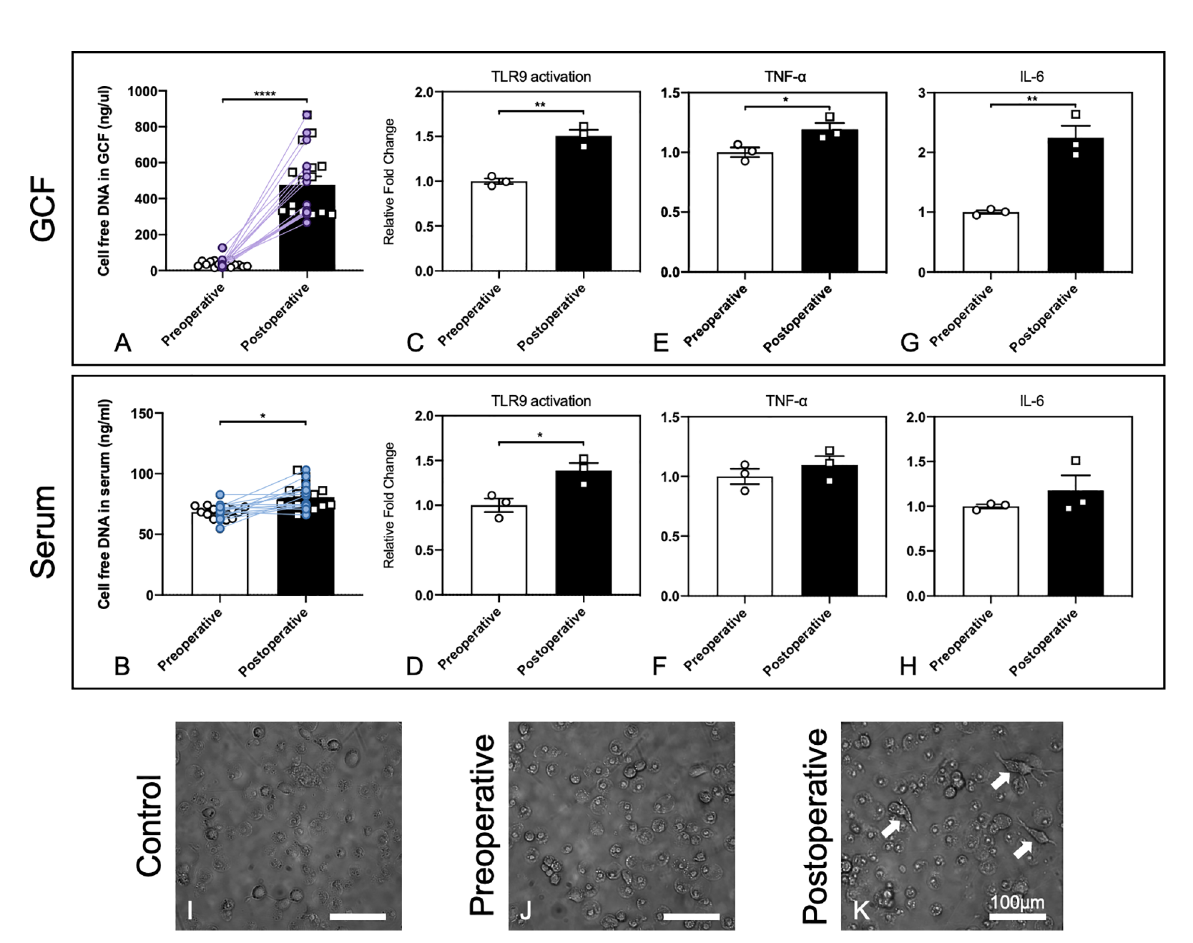
FIGURE 1 GCF and serum in patients after alveolar bone grafting induced stronger cfDNA-related innate immune responses. (A, B) Increasing cfDNA levels after alveolar bone grafting in GCF and serum of patients with alveolar bone cleft. Data are means±SEM; * P <0.05, **** P <0.0001 assessed by paired t-test (n=16). (C, D) Activation of HEK-TLR9 reporter cells by GCF and serum from patients with alveolar bone cleft before and after alveolar bone grafting. Data are means±SEM; * P <0.05, ** P <0.01 by Student ’ s t- test ( n =3). (E, F) TNF- a expression activated by GCF and serum from patients with alveolar bone cleft before and after alveolar bone grafting. Data are means±SEM; * P <0.05 by Student ’ s t- test ( n =3). (G, H) IL-6 expression activated by GCF and serum from patients with alveolar bone cleft before and after alveolar bone grafting. Data are means±SEM; ** P <0.01 by Student ’ s t- test ( n =3). (I – K) Morphological changes of macrophages by patients ’ GCF after alveolar bone grafting. Arrows show signi fi cant morphological changes in cells. Scale bar, 100 m